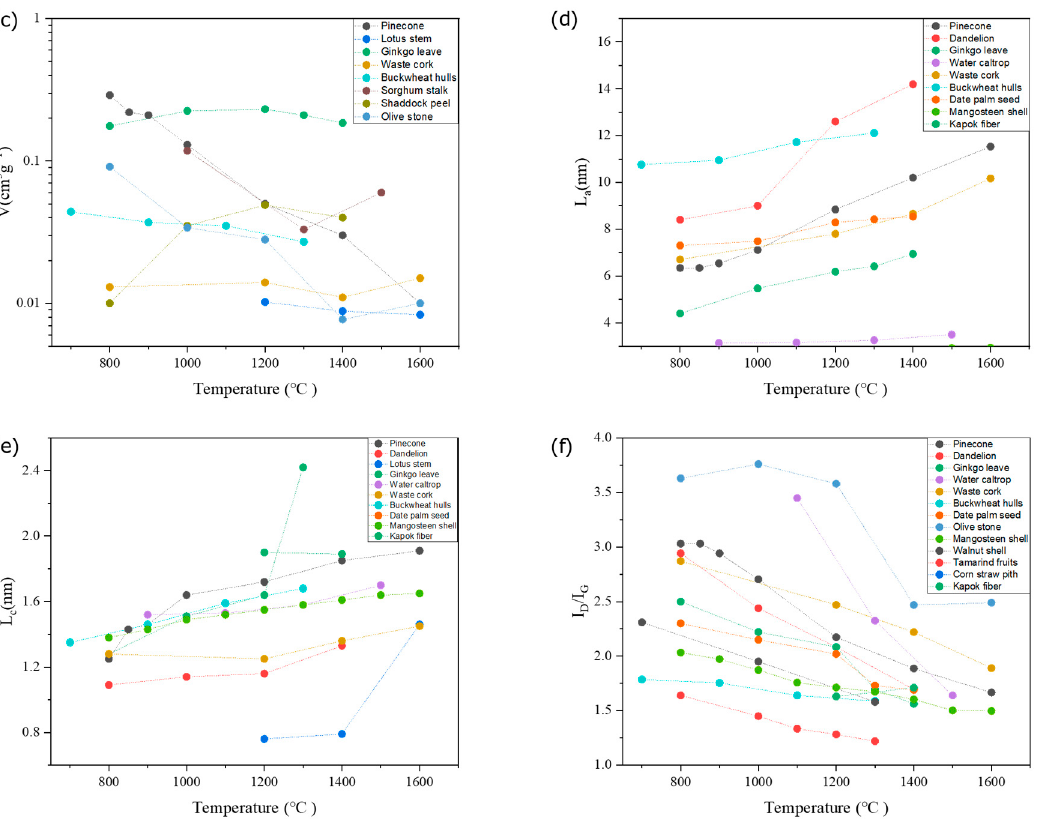
Figure 5. Effect of the carbonization temperature on hard carbon structure: Effect of the carbonization temperature on ( a ) d 002 ; ( b ) SSA; ( c ) V; ( d ) L a ; ( e ) L c ; and ( f ) I D /I G [55,56,58,59,81,84,88–91].